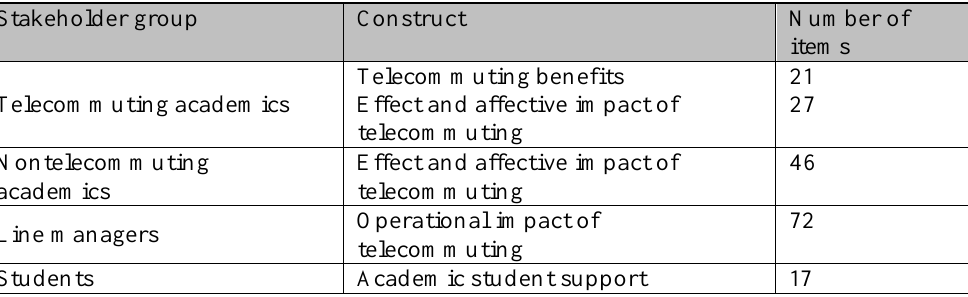
Research Construct and Number of Items Stakeholder